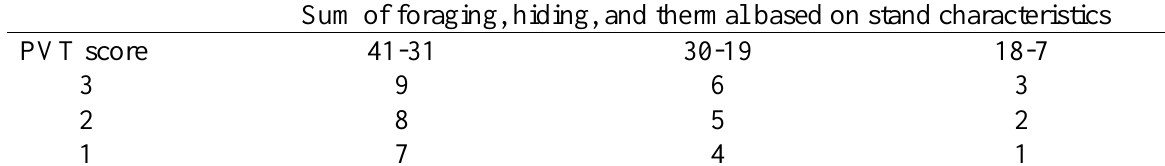
Table A10.1 Description of how the Landscape score and PVT are combined Sum of foraging, hiding, and thermal based on stand characteristics PVT